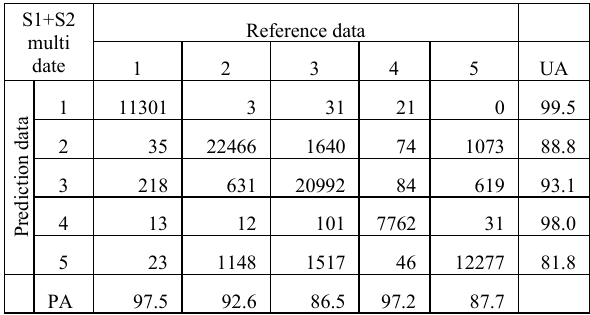
Table 7. Error matrix for the XGB classification